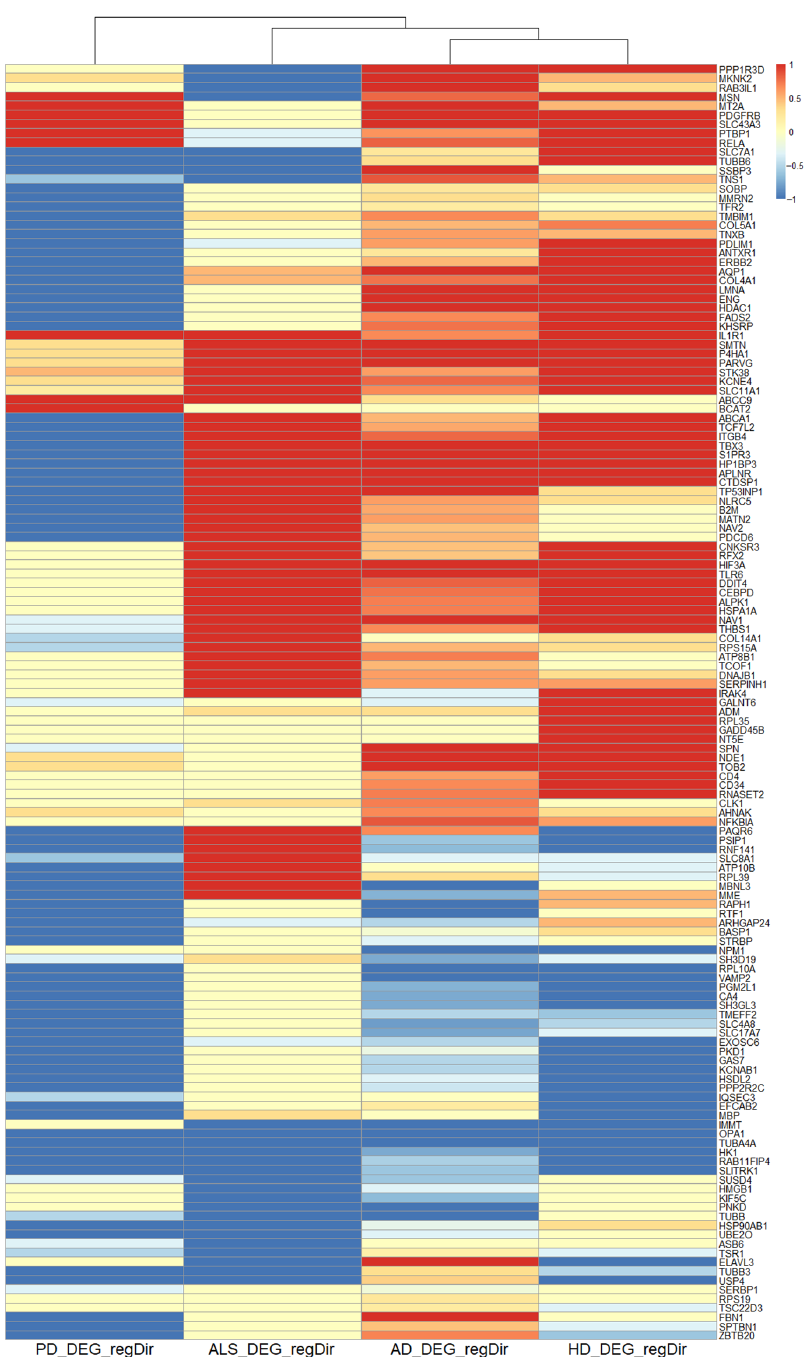
Figure 4. Heatmap with hierarchical clustering results of the mean regulation of all 139 genes that were maintained in all four NDD transcriptomic data. The clustering led to an inner cluster containing HD and AD transcriptomic data. This cluster was next clustered to the ALS transcriptomic data and finally these three NDD were clustered to PD. Colors represent the mean direction of regulation (see. Equation